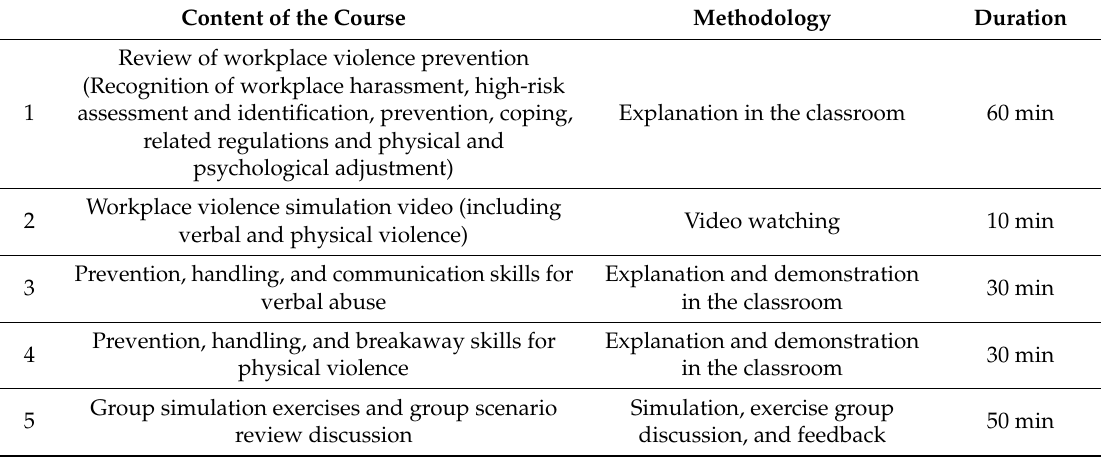
Table 1. Content of the workplace violence simulation training